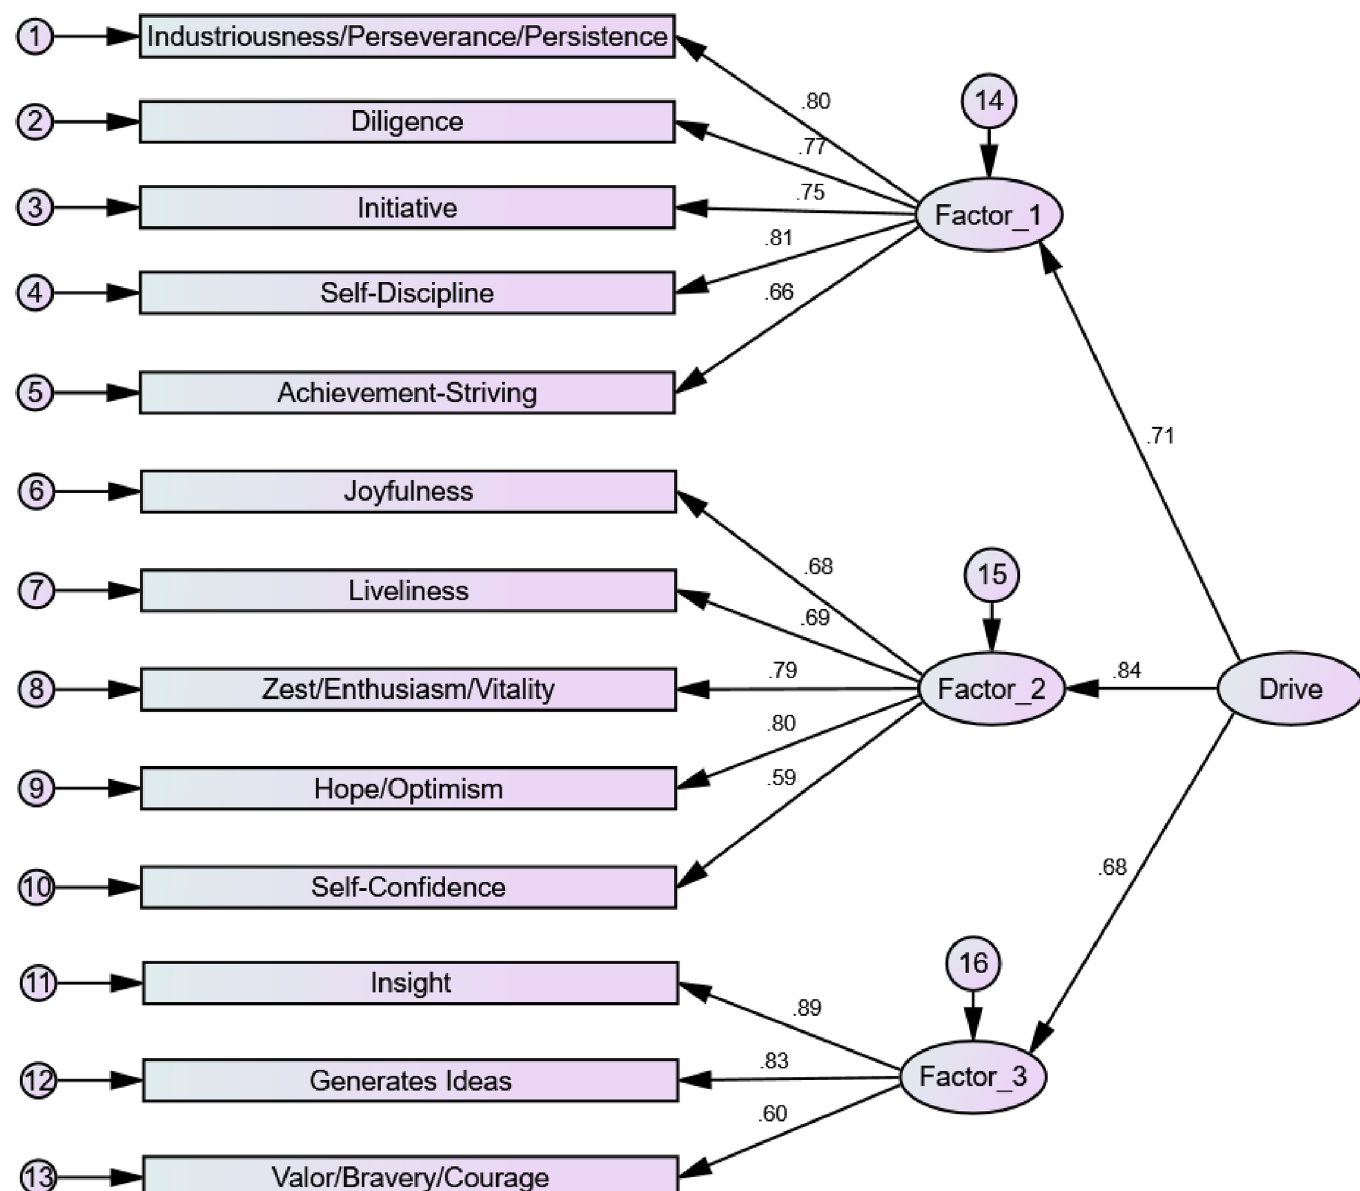
Fig 1. Confirmatory Factor Analysis results for the Drive: International Personality Item Pool version in the Eugene-Springfield community sample ( N = 496).